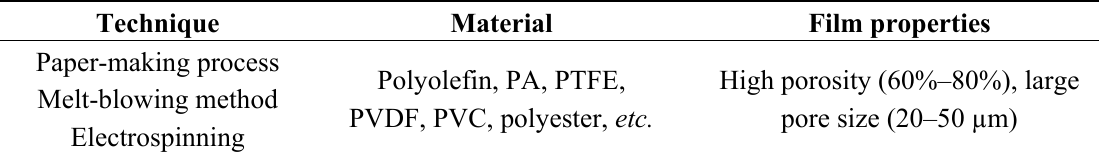
Table 3. Fabrication of nonwoven